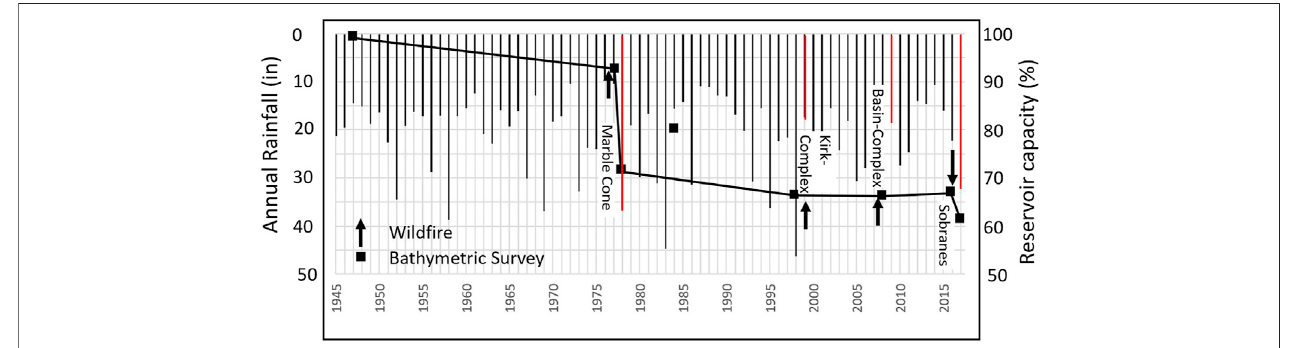
FIGURE2| AnnualrainfallatSanClementeDamandreservoircapacityatLosPadresReservoir.Red-highlightedrainfallyearsoccurredimmediatelyafterawild fi re. Data from Smith et al. (2009), Smith et al. (2018). Bathymetric survey in 1984 is problematic, given that no dredging occurred to increase capacity. It is ignored in our